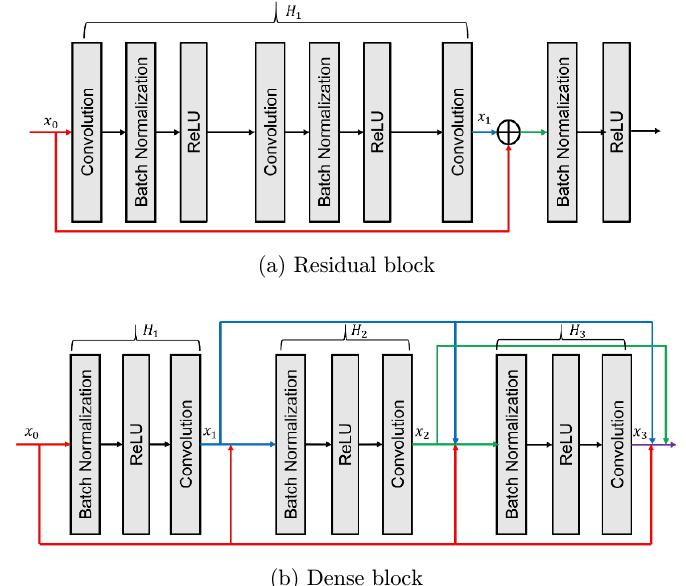
Fig. 1. The di®erence between the residual block and densely connected block. (a) Architecture of a typical residual block and (b) Architecture of a typical 3-layer dense